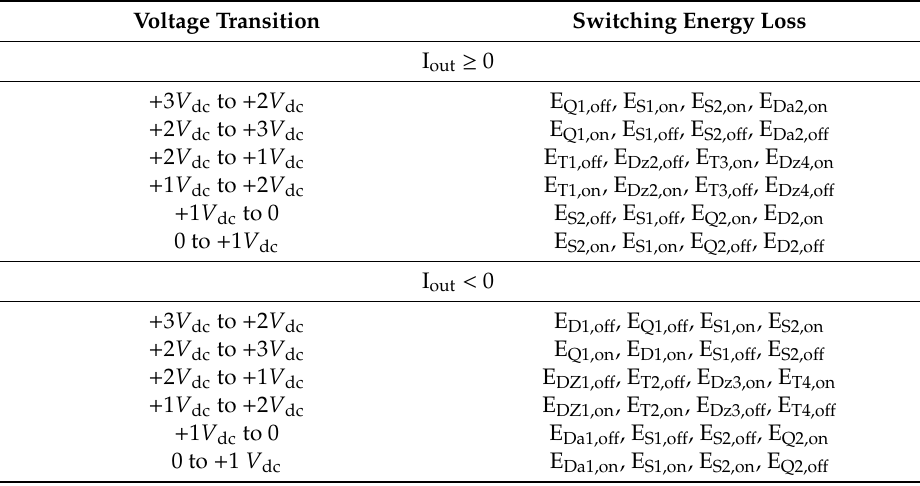
Table 5. Switching energy loss of the phase a components in the N -level inverter proposed in